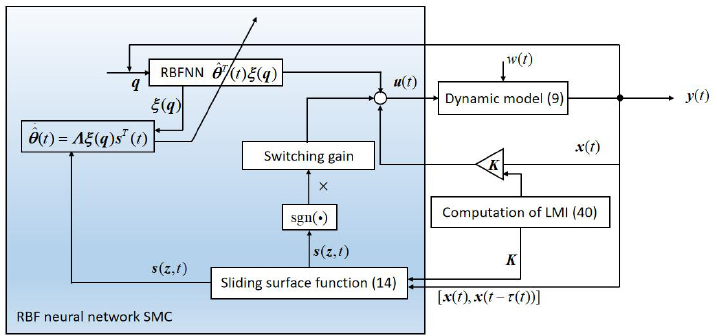
Figure 4. Structure of the